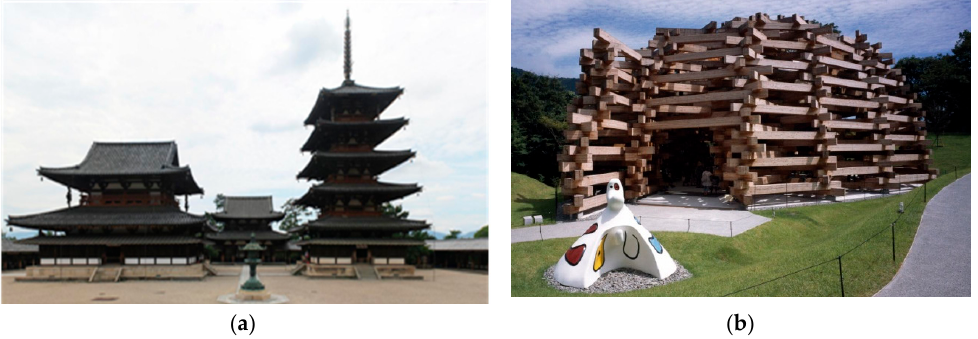
Figure 2. Examples of Kumimono buildings ( a ) Horyu ‐ jidi Ikaruga temple, 607 A.D., from [6]. ( b )